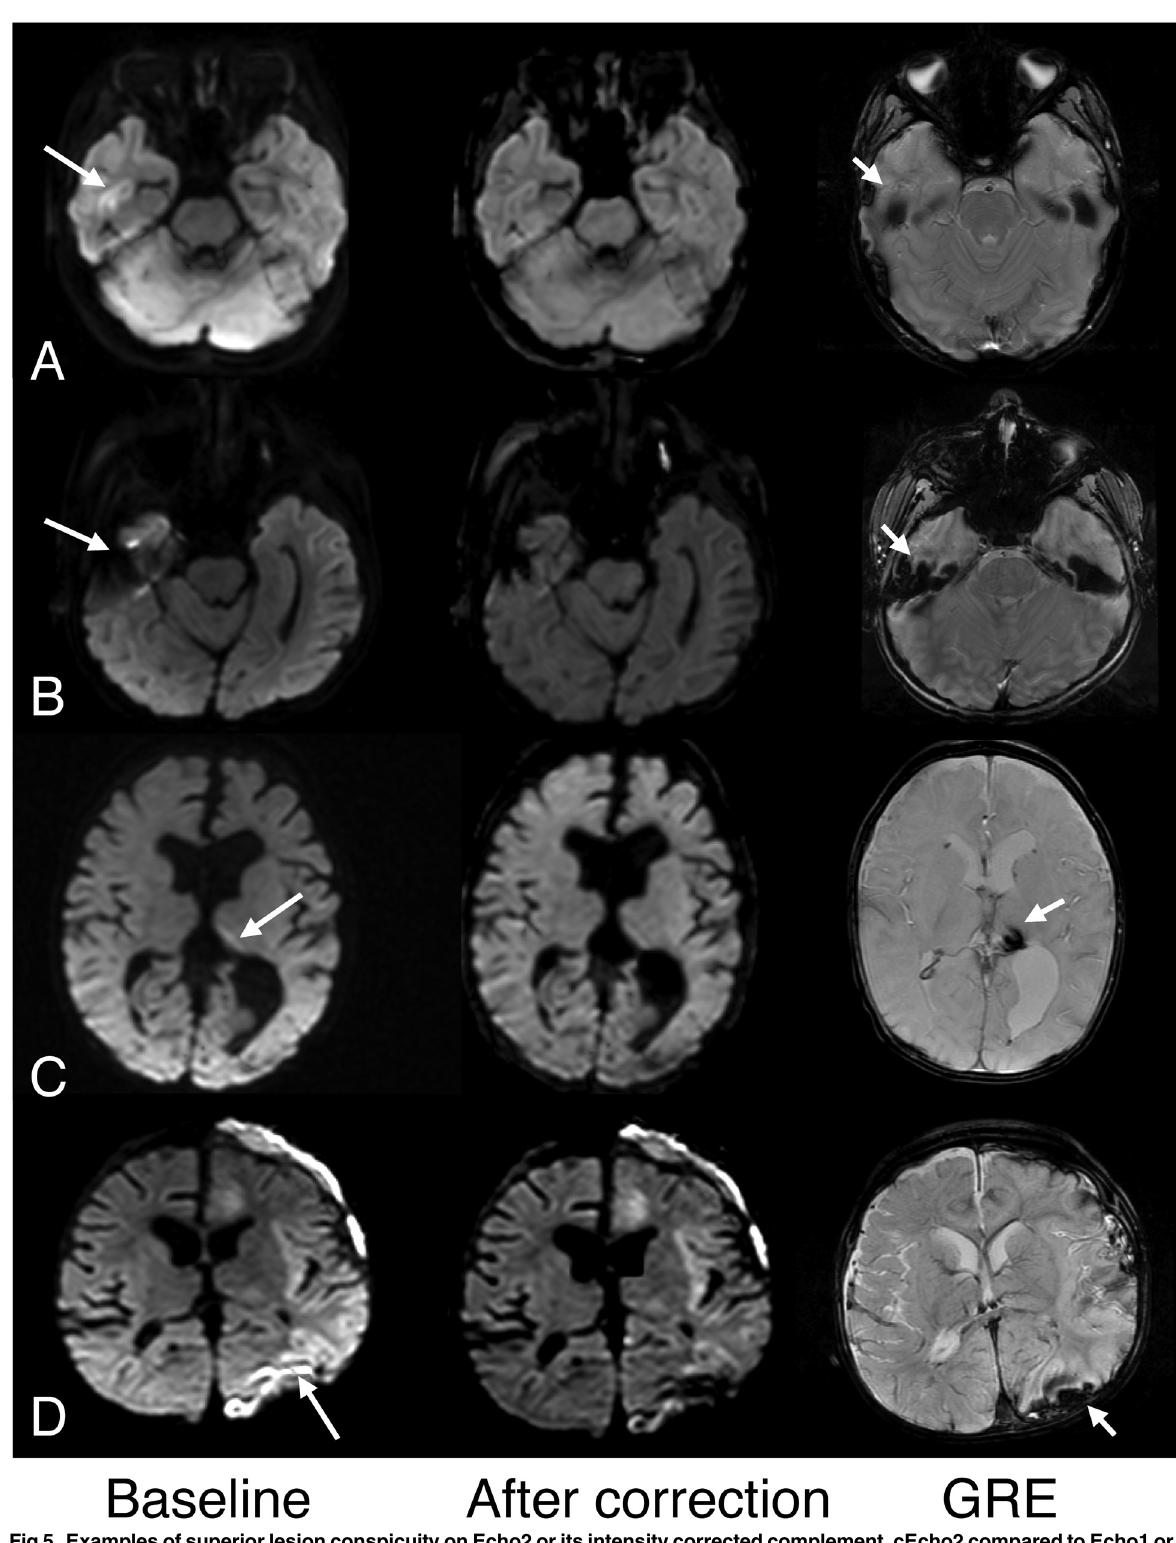
Fig 5. Examples of superior lesion conspicuity on Echo2 or its intensity corrected complement, cEcho2 compared to Echo1 or cEcho1. A. Note improved conspicuity of cerebral contusions (arrows) in this 3-year old boy who fell from a 2-story building on Echo2 compared to Echo1. B. Reduced diffusivity from hypoxic-ischemic encephalopathy is more distinctly depicted on Echo2 (long arrow) compared to Echo1 in a 7-day old male infant who was